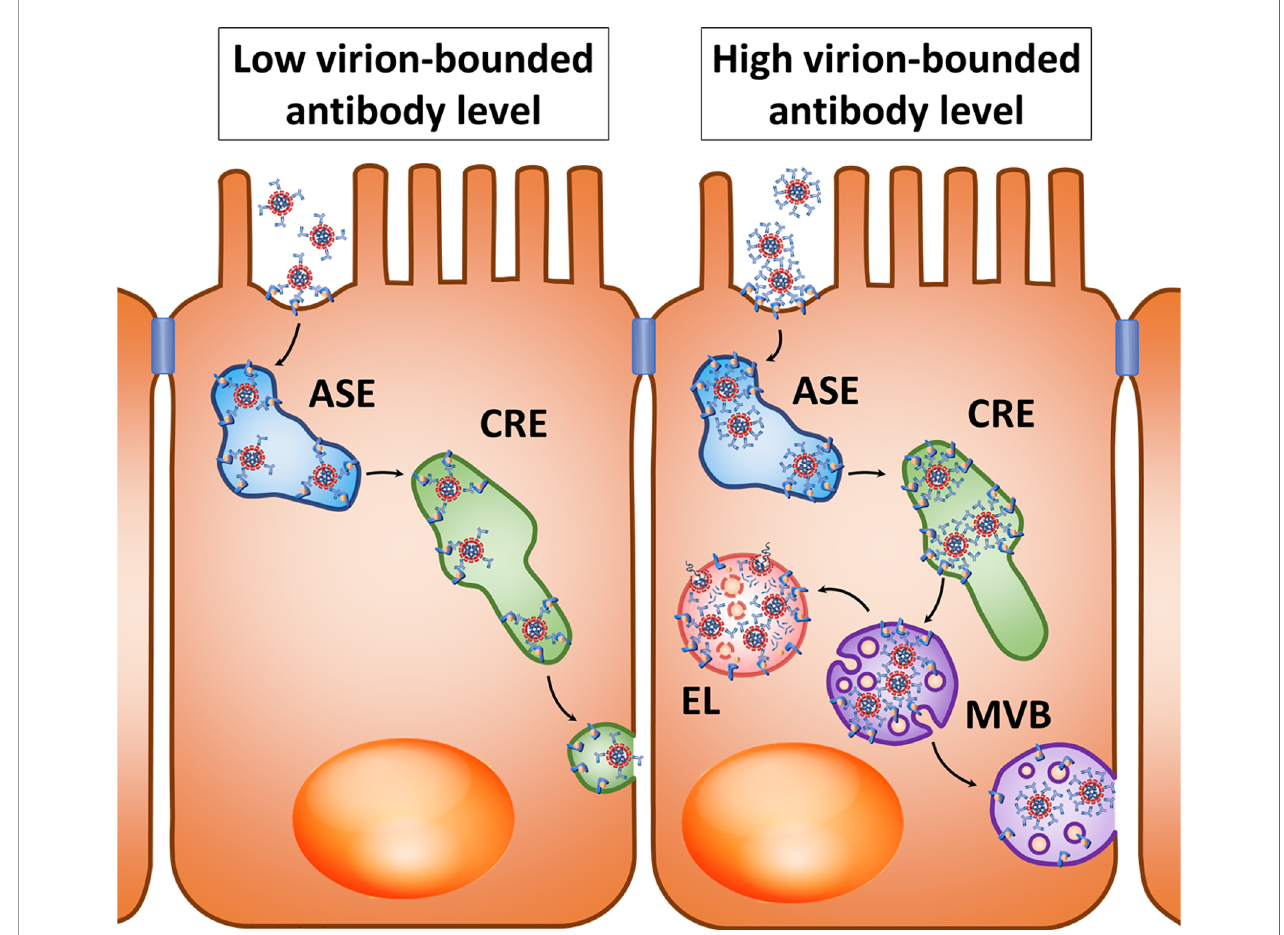
FIGURE 2 | Hypothetical pathways for transcytosis of the opsonized SARS-CoV-2 after interaction with the FcRn, Fc-region receptor in a polarized cell. Left : At a relatively low virion-bounded antibody level, coronavirus transcytosis is possible through the tubules of apical sorting endosome (ASE) and common recycling endosome (CRE). Right : With a high density of virion-bounded antibodies or virion agglomerate formation, sorting in CRE may be changed, resulting in virions entering the multivesicular bodies (MVBs) that can either fuse with lysosomes to form endolysosome (EL), or fuse with the cytoplasmic membrane when lysosome fusion is